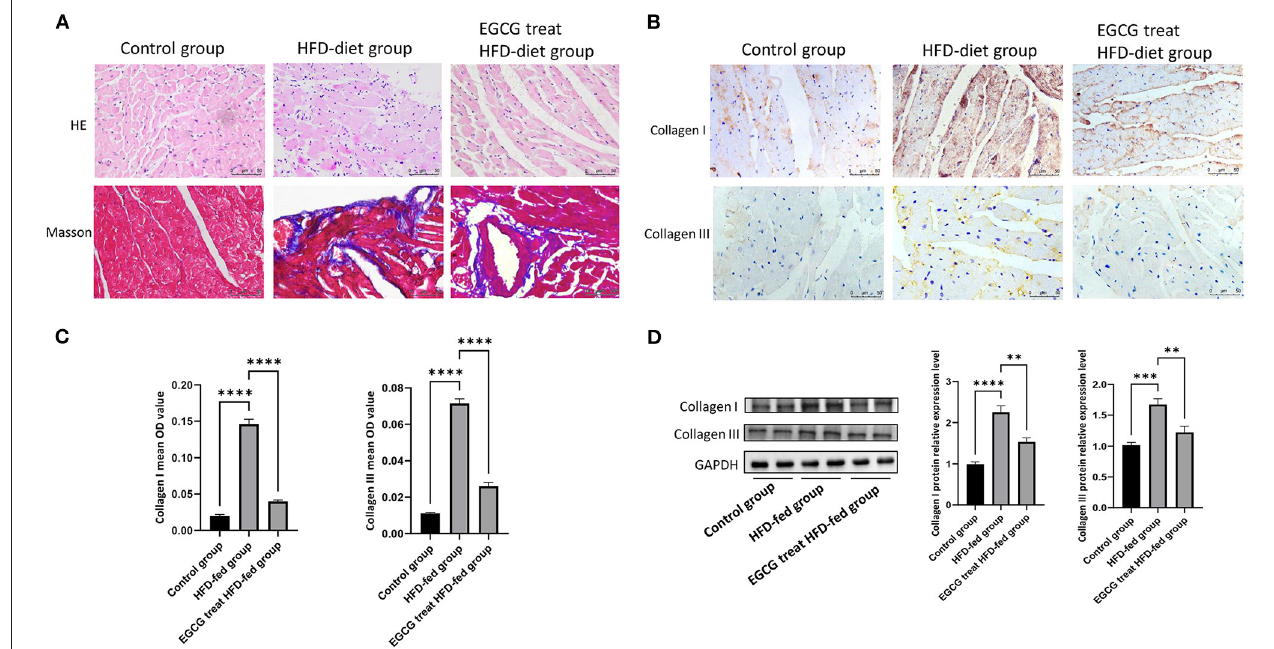
FIGURE 2 | EGCG alleviated the pathology of obesity-induced myocardial fibrosis. (A) Effect of EGCG on obesity-induced myocardial fibrosis in heart tissue by HE and Masson staining; (B) Effect of EGCG on the deposition of collagen I and collagen III in heart tissue by Immunohistochemical staining; (C) The mean OD values of collagen I and collagen III in heart tissue by Immunohistochemical staining; (D) Effect of EGCG on the expression of collagen I and collagen III proteins were detected by western blot with GAPDH as a loading control in the heart. (* p < 0.05, ** p < 0.01, *** p <